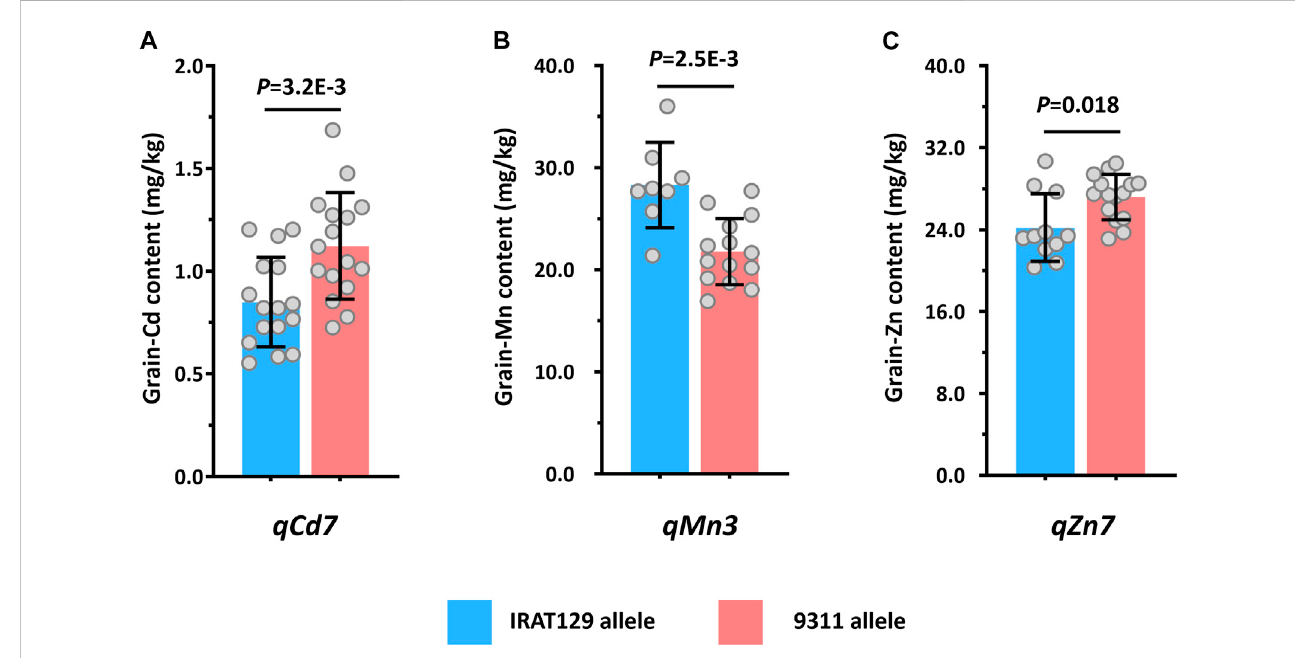
Validation of the detected QTLs by analyzing the performance of the three QTLs in different planting environments. Comparison of the performance of grain-Cd, grain-Mn, and grain-Zn in the presence of qCd7 (A) , qMn3 , (B) , and qZn7 (C) in a paddy fi eld contaminated with Cd.